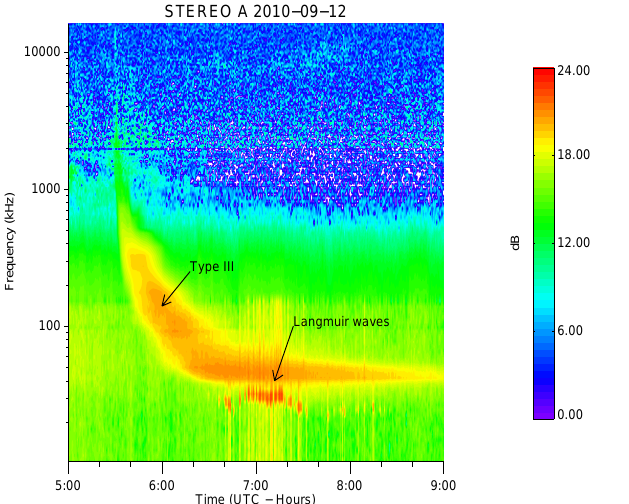
Fig. 1. Dynamic spectrum of a local type III radio burst (fast drifting emission from ∼ 5MHz down to ∼ 30kHz) and associated Lang- muir waves (non-drifting emissions in the frequency interval 27– 32kHz).